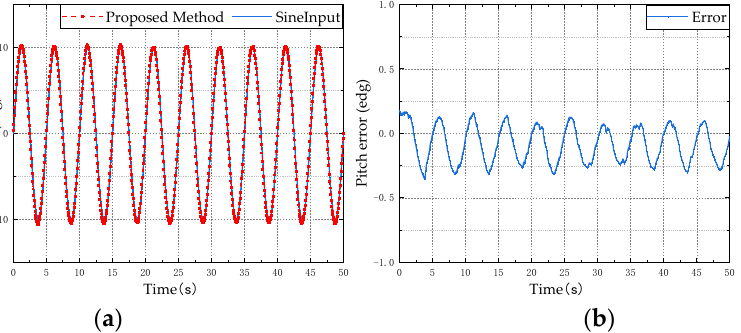
Figure 6. Pitch angle simulation test results: ( a ) is the estimation result of the proposed method; ( b ) is the error between the estimated value and the reference value.